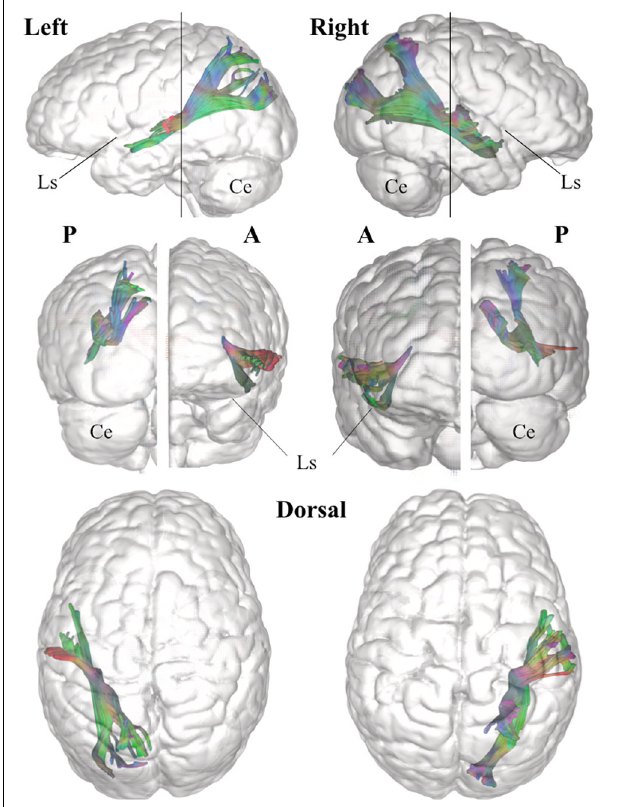
FIGURE 6 | Three-dimensional reconstruction within a “glass-brain” of origin, course, and terminations of the MdLF (complete) of the left and right side on sagittal projection (first row) , on coronal projection (from both posterior and anterior view, second row ) and axial dorsal view (third row) . The color of the white matter pathway has been maintained directional to show details about the temporal and parieto-occipital terminations, which clearly bend from the stem of the pathway. A, anterior view; P, posterior view; Ls, lateral sulcus; Ce, cerebellum.